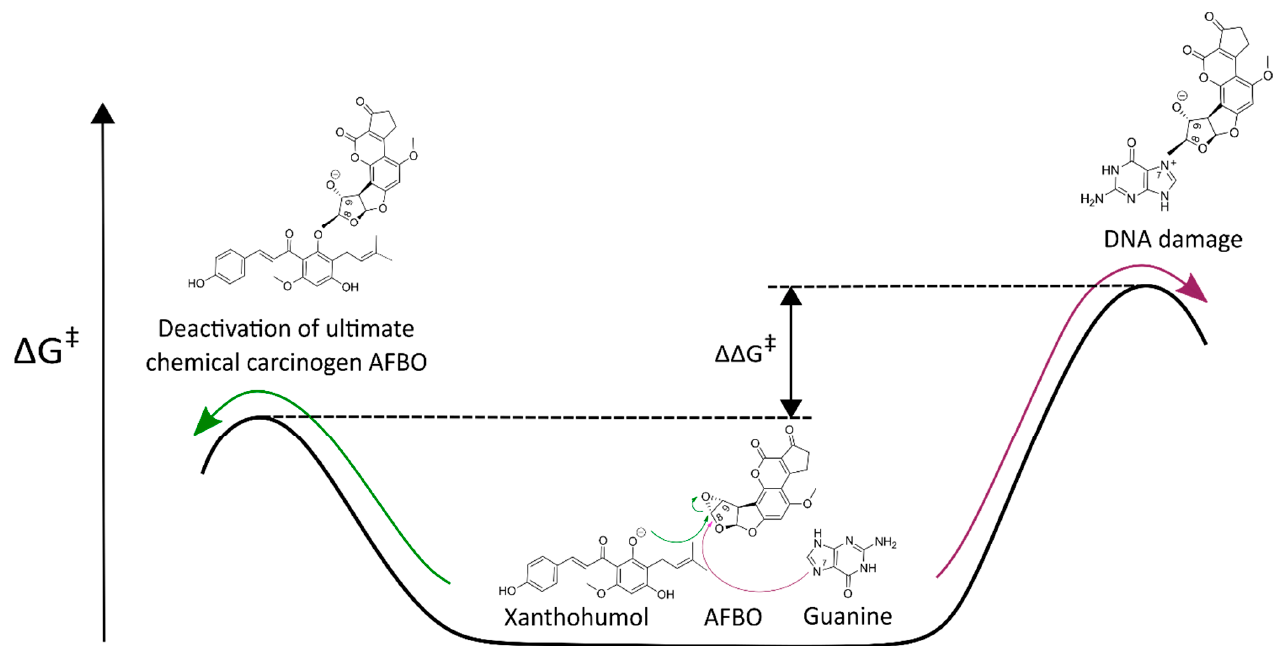
Figure 2. Competing reactions of the ultimate chemical carcinogen AFB1 exo-8,9-epoxide (AFBO) with xanthohumol (XN; green arrow) and guanine (violet arrow).